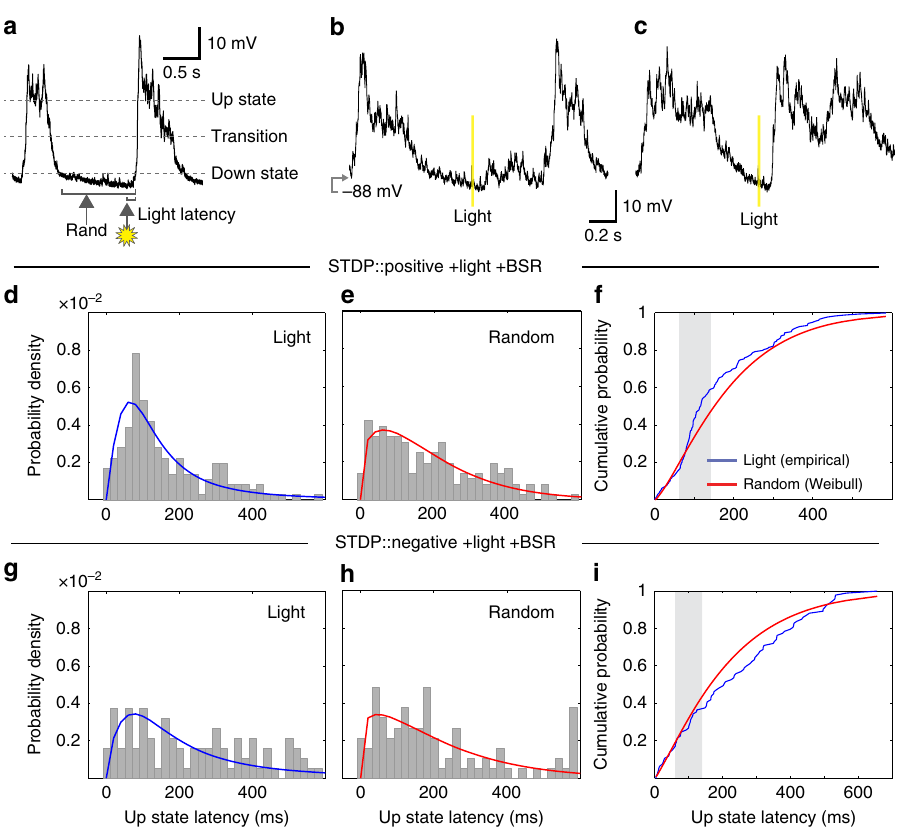
Fig. 3 Modulation of STDP by the conditioned light stimulus is associated with increased probability of up state initiation in SPNs. a Latencies to the up state (detected using the transition level indicated) were measured for both a random event in the down state and from the light event. b Representative example of instances in which a light event failed to initiate an up state and c when an up state was initiated. d , g Probability distribution function (PDF) of latencies to the next up state following all light events plotted for positive ( n = 177; d ) and negative ( n = 94; g ) pairings groups, and fi tted with a log-logistic distribution curve. e , h For comparison, the PDF of latency to the up state from a random point in the same down state was calculated for both groups and fi tted with a Weibull distribution curve. The light-evoked latencies for the positive pairings group were signi fi cantly different from, and hence unlikely to have been sampled from, the random latency distribution (Kuiper ’ s test , P < 0.00001); although they were not signi fi cantly different in the negative pairings group ( P = 0.16). f , i Cumulative distribution functions (CDF) for the light and random events were constructed, and the probability of an up state occurring at the expected interval of 60 – 140 ms ( shaded region ) following the light was calculated from the CDFs by subtracting the probability of an up state occurring during this period randomly from the probability of an up state occurring during this period following a light event. In the positive pairings group (+0.13), but not the negative pairings group (+0.03), light events showed a notable probability above chance of initiating an up